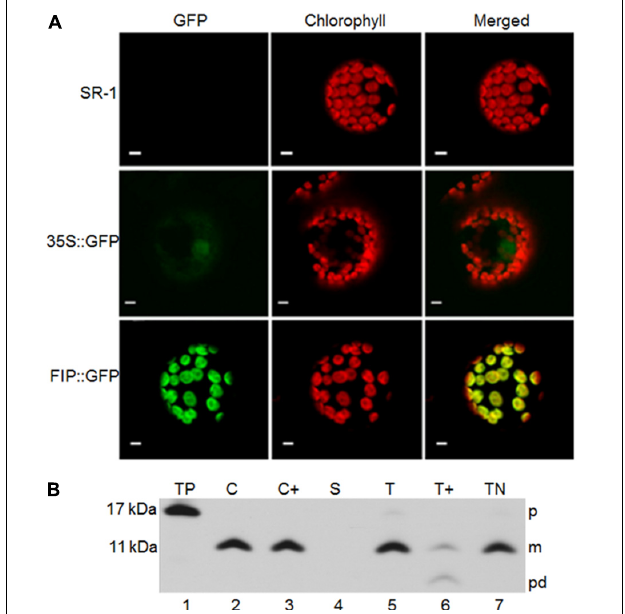
FIGURE 2 | Subcellular localization of FIP. (A) In vivo chloroplast localization of the FIP::GFP fusion introduced by Agrobacterium tumefaciens –mediated transfection in tobacco protoplasts. Fluorescence images were obtained using a confocal laser scanning microscope. green fluorescent protein (GFP) corresponds to the fluorescence detected in the green channel. Chlorophyll, detected in the far-red channel, corresponds to the chloroplast autofluorescence signal. Chlorophyll + GFP corresponds to the merging of the far-red and green channels. Yellow represents the co-localization of green and red signals. All scale bars represent 5 µ m. SR-1 corresponds to wild type Nicotiana tabacum non-transformed protoplasts; 35S::GFP corresponds to expression of GFP driven by the constitutive 35S promoter of Cauliflower mosaic virus (CaMV); FIP::GFP corresponds to expression of FIP::GFP fusion driven by the constitutive 35S promoter of CaMV (B) pFIP is imported into isolated chloroplasts and integrated into thylakoids. Radiolabeled in vitro -translated pFIP (TP, lane 1) was incubated with intact isolated pea chloroplasts in a reaction containing 5 mM ATP and ∼ 100 µ E/m − 2 sec − 1 light at 25 ◦ C for 20 min. Intact chloroplasts were recovered from the reaction (C, lane 2) and treated with thermolysin (C+, lane 3). Untreated intact chloroplasts were fractionated into stroma (S, lane 4) and thylakoids. Thylakoid aliquots were washed with import buffer (T, lane 5), treated with thermolysin (T+, lane 6), or treated with 100 mM NaOH (TN, lane 7). Samples were analyzed by SDS–PAGE on 12.5% gels and by fluorography. The precursor, mature form, and product degradation are designated p, m, and pd, respectively, on the right side of the panels. M -values on the left side were estimated from their migration compared with standard marker